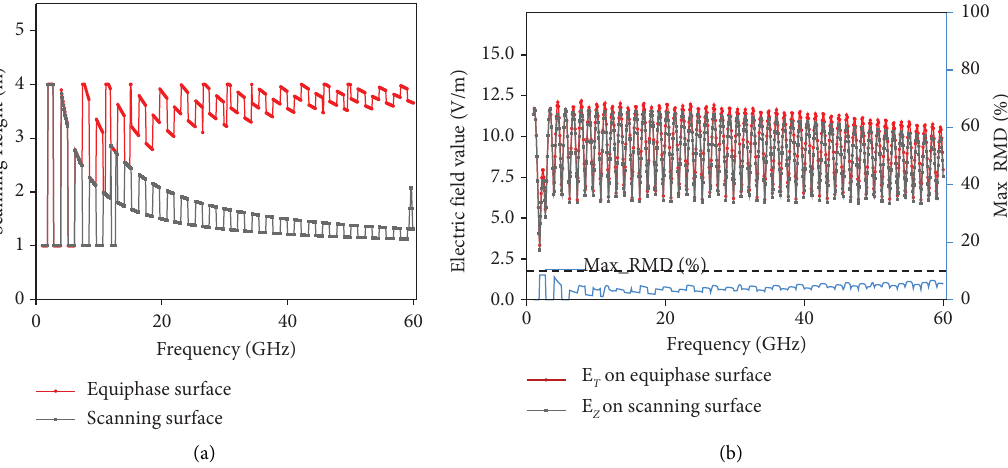
Figure 7: Results of a vertical dipole measured in a FAC: length h � 6U and distance d � 10m. (a) Scanning height corresponds to the maximum electric felds on the two surfaces. (b) Relative deviation of the maximum electric felds on the two surfaces.